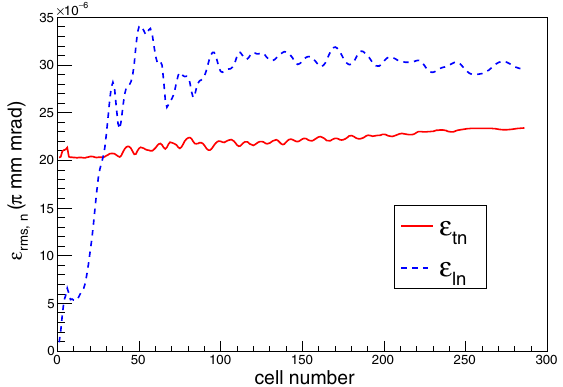
FIG. 5. Trajectories of the phase-advance ratio and depression of epRFQ on the Hofmann chart. The longitudinal/transverse emittances ratio of this Hofmann chart is 1.3.